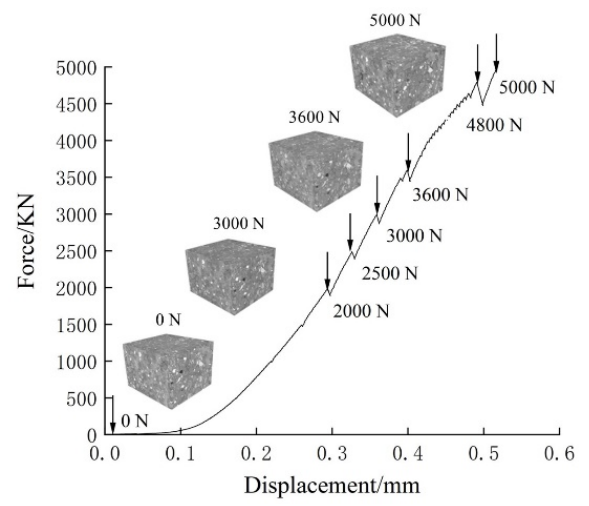
Figure 2. Force-displacement curve.